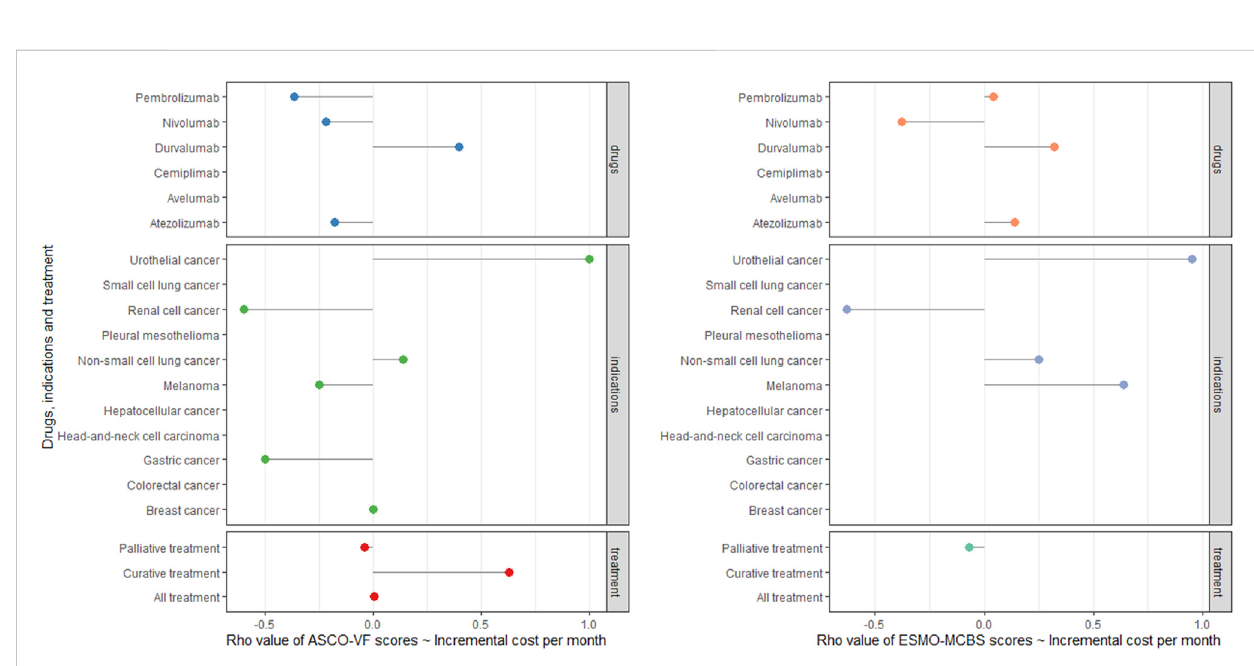
FIGURE 4 Cleverland of correlation analyses among ASCO-VF scores, ESMO-MCBS scores and incremental cost in six PD-1/PD-L1 inhibitors and 11 indications.